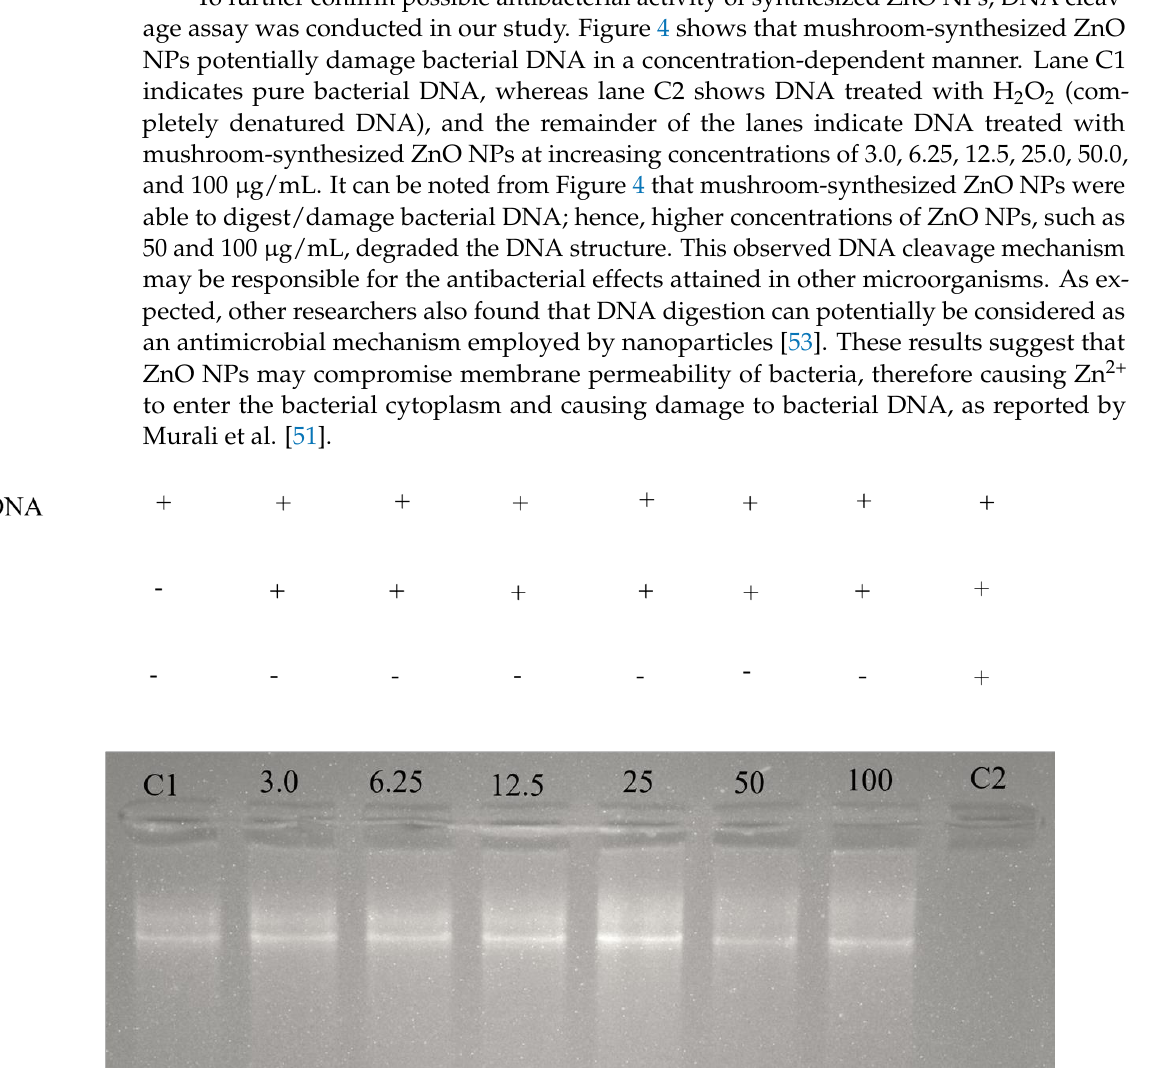
Figure 4. The gel electrophoresis image of DNA cleavage of P. ostreatus -synthesized ZnO NPs. C1 (control with pure pET30 DNA), C2 (control with DNA+ H 2 O 2 ), lanes 3.0–100 represent increasing concentrations of P. ostreatus -synthesized ZnO NPs in µg/mL.